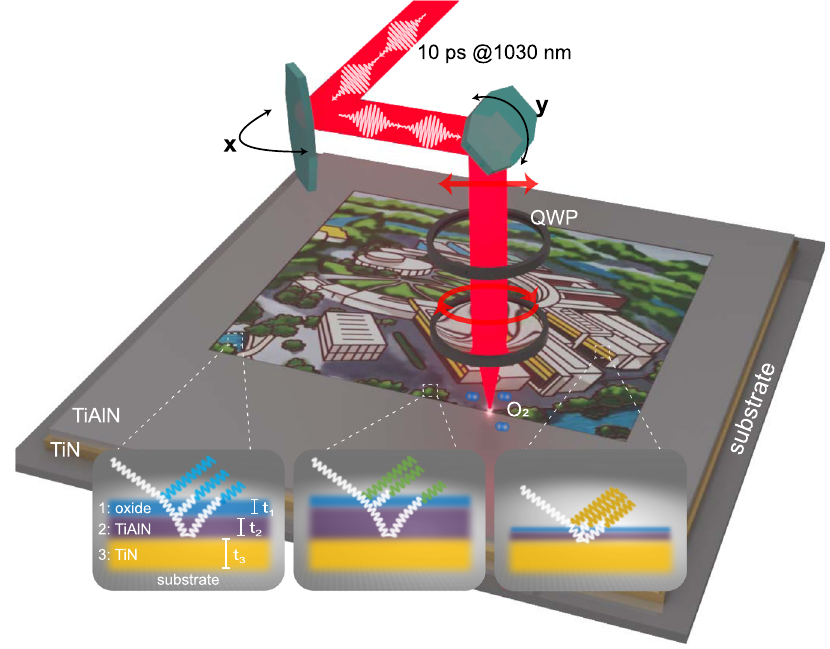
Fig. 1 | Scheme of surface coloring by ultrafast laser. The structural colors ori- ginate from laser-induced oxide layer on highly absorbing while hard ceramic titaniumaluminumnitride(TiAlN) fi lm.Thetitaniumnitride(TiN) fi lmbehavesasa re fl ector. QWP: quarter-wave plate. Large-scale printing is achieved by